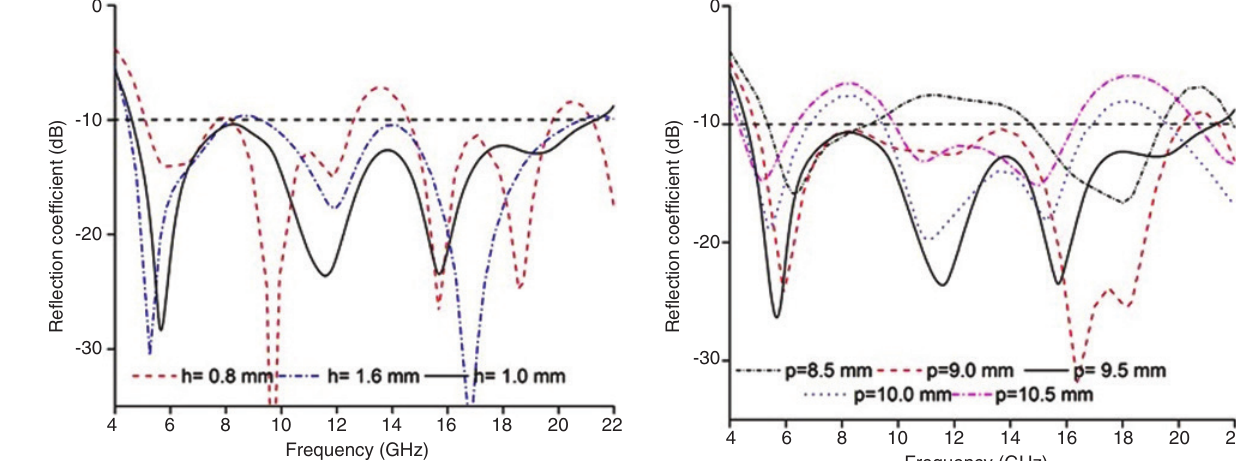
Figure 9: Reflection coefficient for different values of ground pane width “p.”